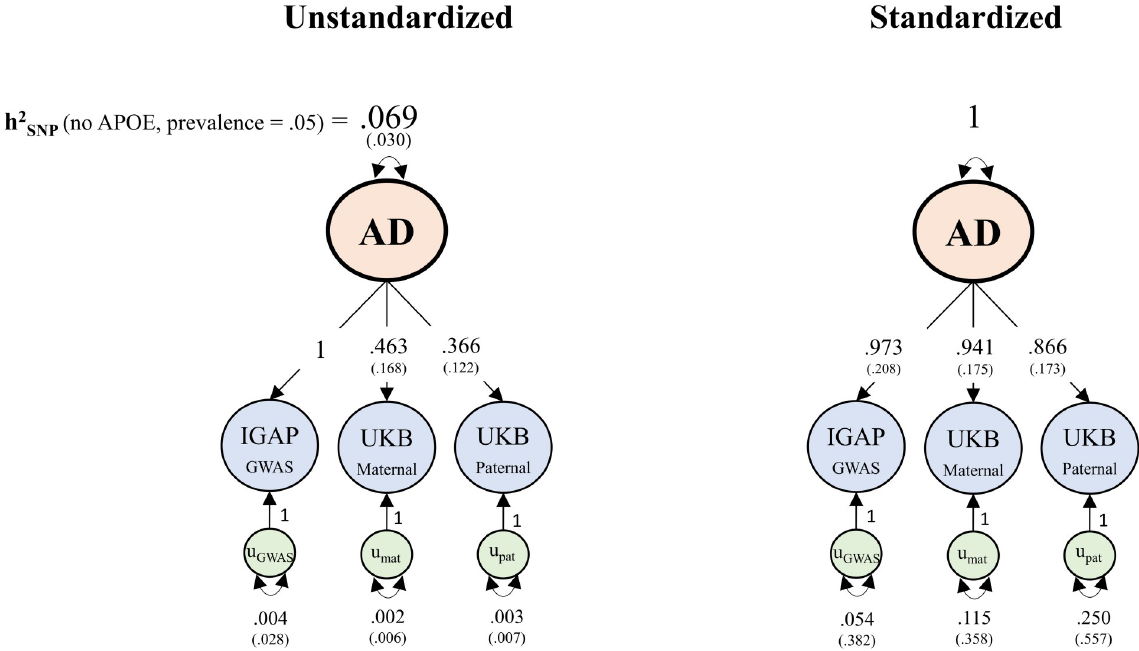
Fig 3. Unstandardized (left) and standardized (right) empirical results from multivariate genetic analysis of Alzheimer’s disease. The liability- scale SNP heritability estimate of 6.9% is on the scale of the direct GWAS, and is for common variants (MAF � .01) outside of the MHC and APOE regions, using the AD population prevalence of 5%. u = residual genetic